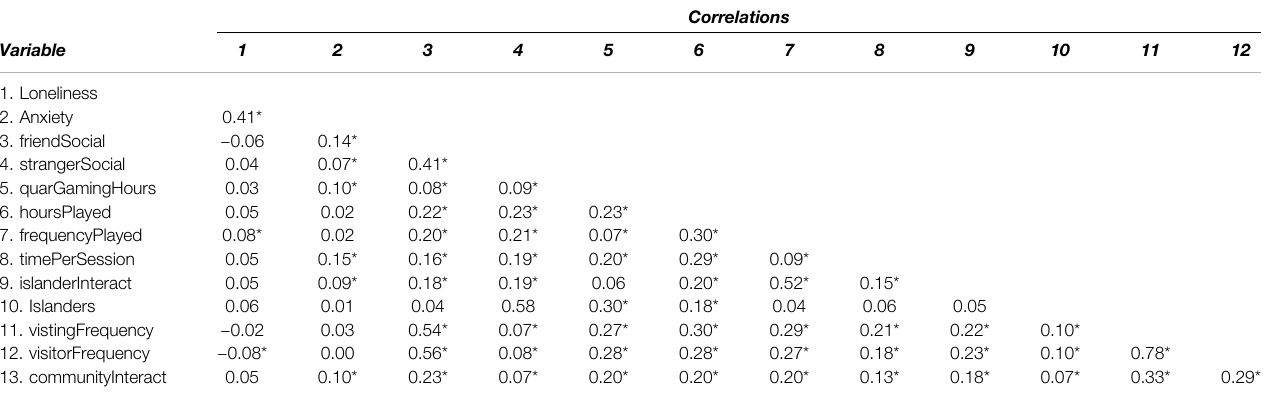
TABLE 2 | Correlations.